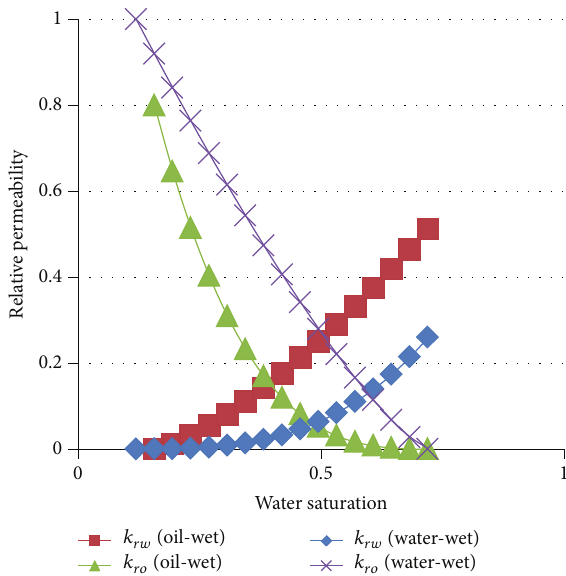
Figure 3: Relative permeability curves for different wettability conditions.